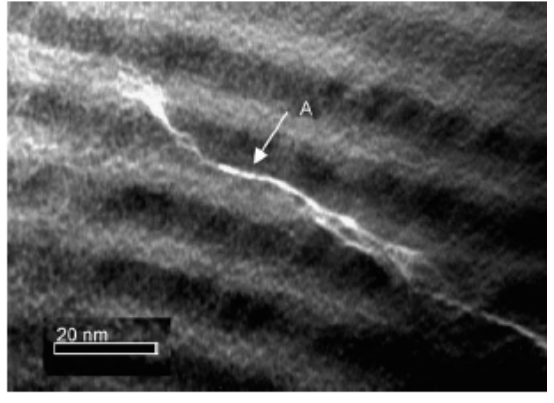
Figure 28: Ti-Al-Si-N coating with TiAlN/Si 3 N 4 multilayer coating showing crack deflection at the interface and within the layer [303]